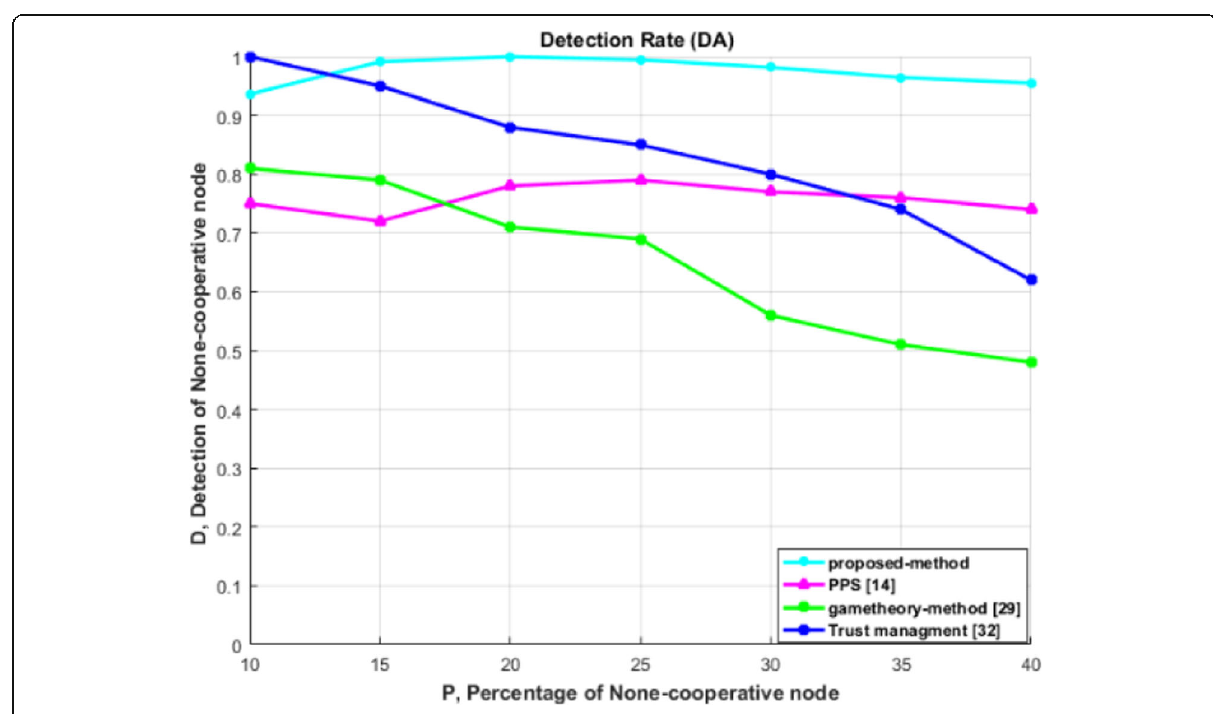
Fig. 9 Comparison of detection accuracy (DA) in